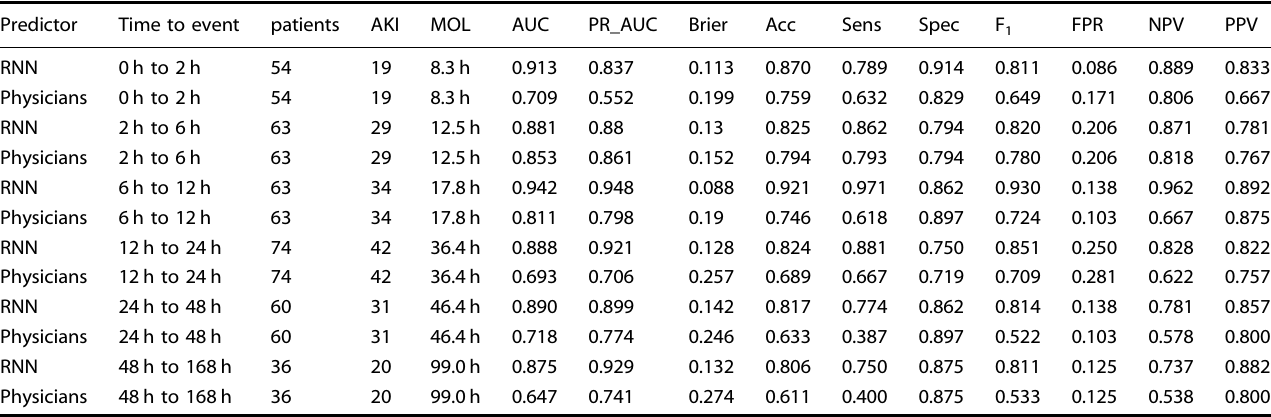
Table 3. Performance metrics of recurrent neural network (RNN) and physicians in temporal dependence to the event.